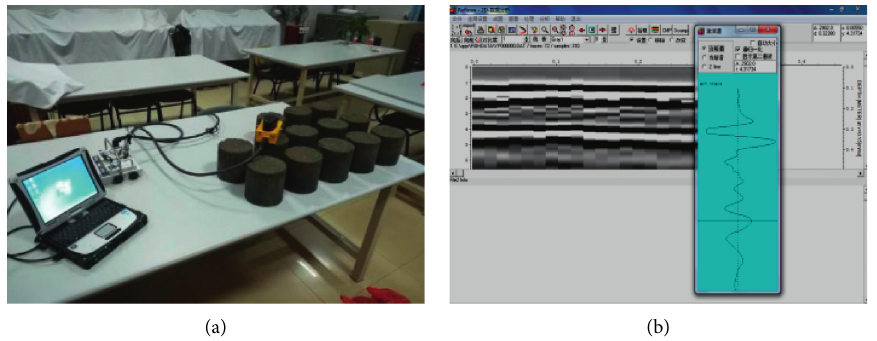
Figure 2: Collection of the dielectric property data of the CSMB specimens.